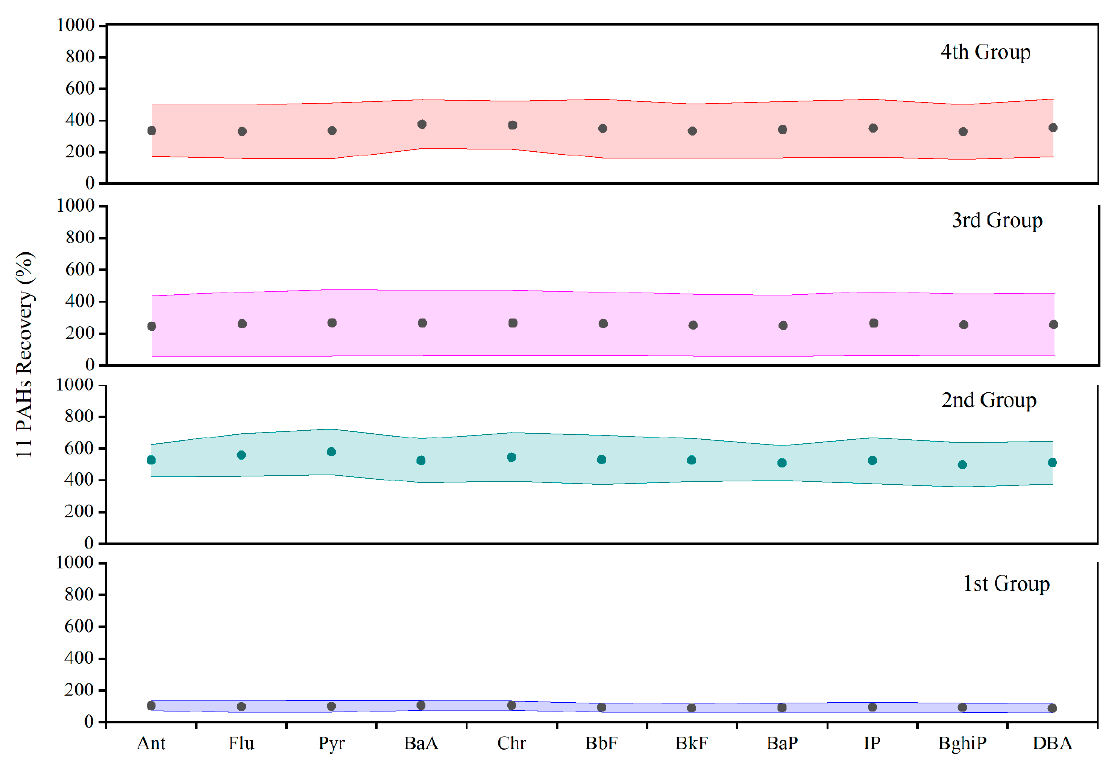
Figure 3. The recoveries of 11 PAHs of ASE pretreatment under the different experimental parameters (shading represents the upper and lower errors).